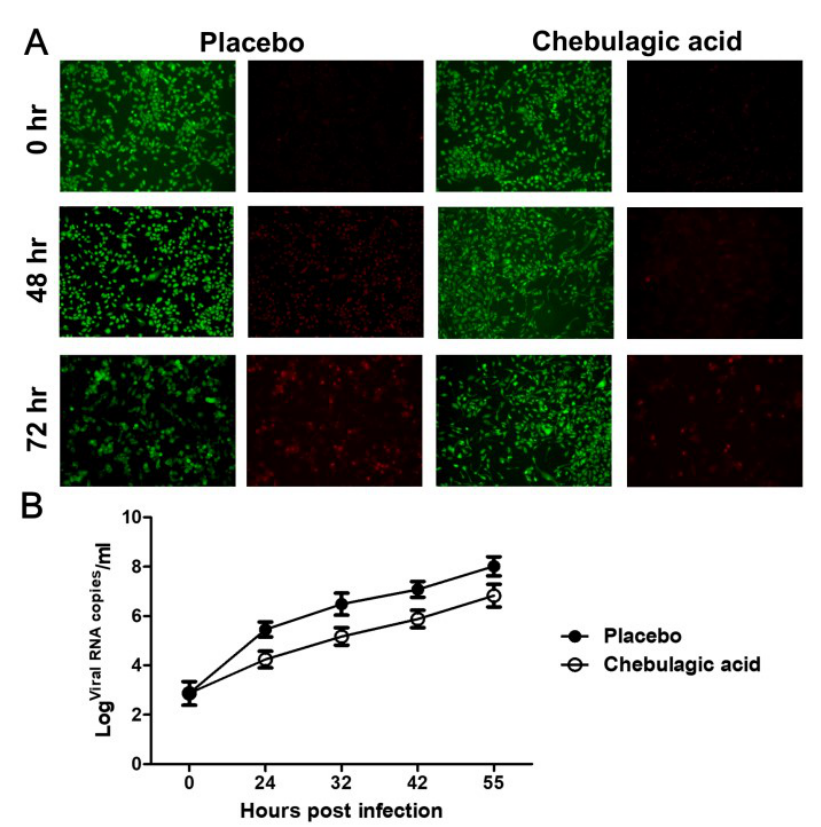
Figure 2. Effect of chebulagic acid on enterovirus 71 (EV71) replication in rhabdomyosarcoma (RD) cells. ( A ) The infected RD cells were treated with chebulagic acid or saline at 2 h post EV71 infection, and then the cytopathic effect (CPE) of the RD cells was observed after AO/EB double staining under a light microscope (100×) at 0 h, 48 h and 72 h post infection, respectively. ( B ) The viral RNA copies in the culture supernatant of the RD cells were detected by quantitative RT-PCR (qRT-PCR). The data are expressed as the mean values of three independent